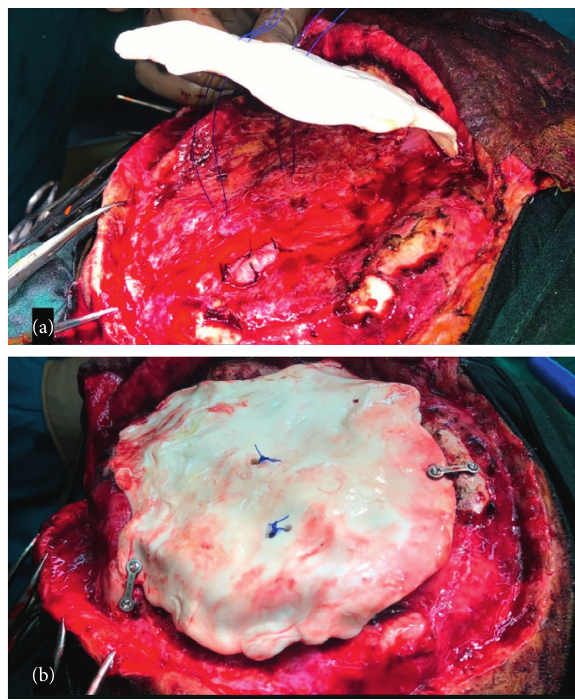
Figure 4: (a) Intraoperative photograph showing placement of central hitch suture across the flattened bone flap. (b) Intraoperative photograph after placement of central hitch suture across the bone